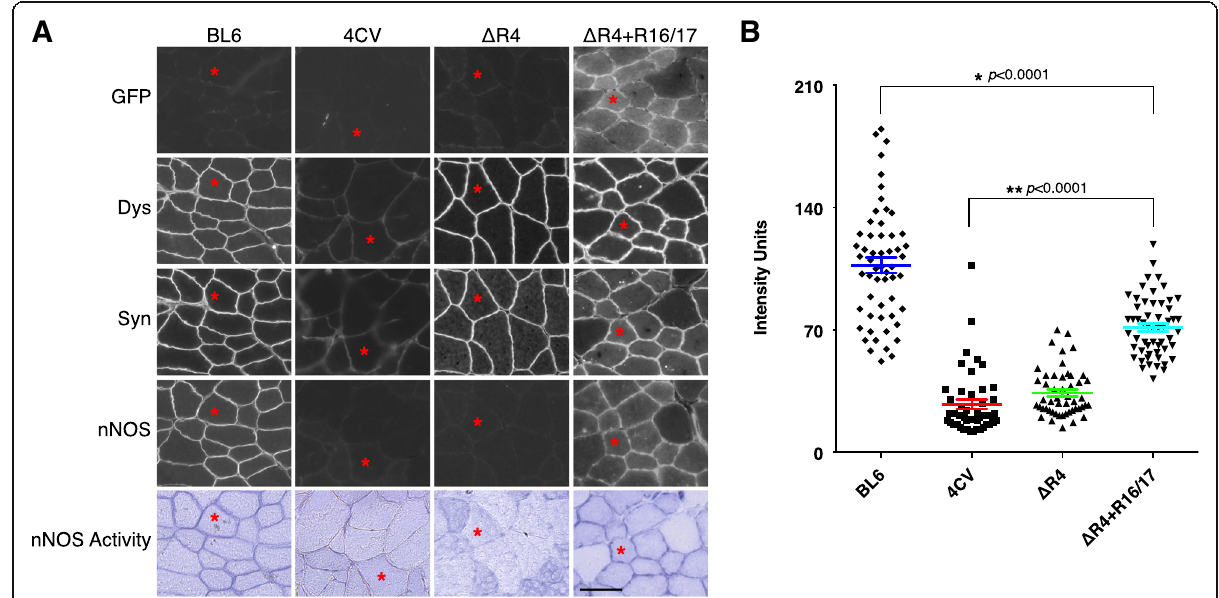
Fig. 4 Sarcolemmal nNOS is successfully restored by systemic delivery of mTAT.R16/17.GFP.Pal protein in Δ R4 mice. a After systemic delivery of mTAT.R16/17.GFP.Pal protein in Δ R4 mice, dystrophin (Dys), syntrophin (Syn) and nNOS were examined on serial sections of the TA muscle. The GFP signal confirmed that mTAT.R16/17.GFP.Pal was transferred to the TA muscle. With R16/17 protein transfer, sarcolemmal nNOS was successfully restored, as shown by nNOS immunostaining and nNOS activity staining at the muscle membrane. Without R16/17 injection, despite the presence of Δ R4 micro-dystrophin and syntrophin at the sarcolemma, sarcolemmal nNOS was still absent. Asterisk: the same myofiber on serial sections. Scale bar=50 μ m. b The signal intensity of nNOS immunostaining was quantified and analyzed by ANOVA. After R16/17 protein transfer, compared to mdx4cv and non-injected Δ R4 mice, sarcolemmal nNOS in Δ R4 mice was statistically improved (** p <0.0001). Sarcolemmal nNOS in the muscle of BL6 is significantly higher than mdx4cv , Δ R4 and Δ R4+R16/17 (* p